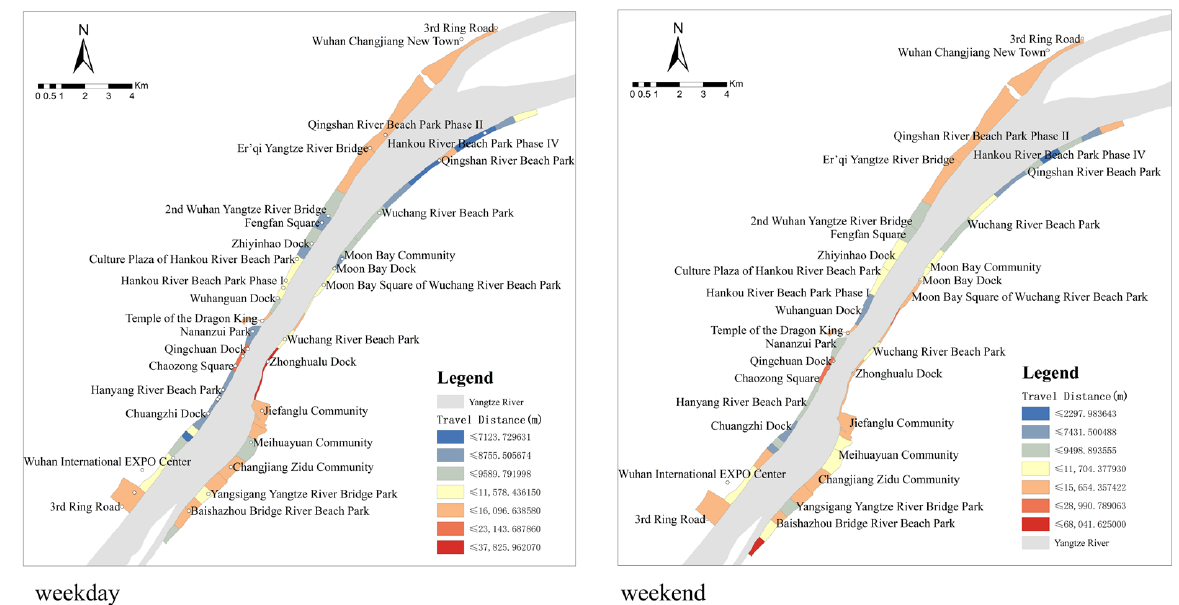
Figure 5. The space distance distribution of the riverside area of Wuhan.